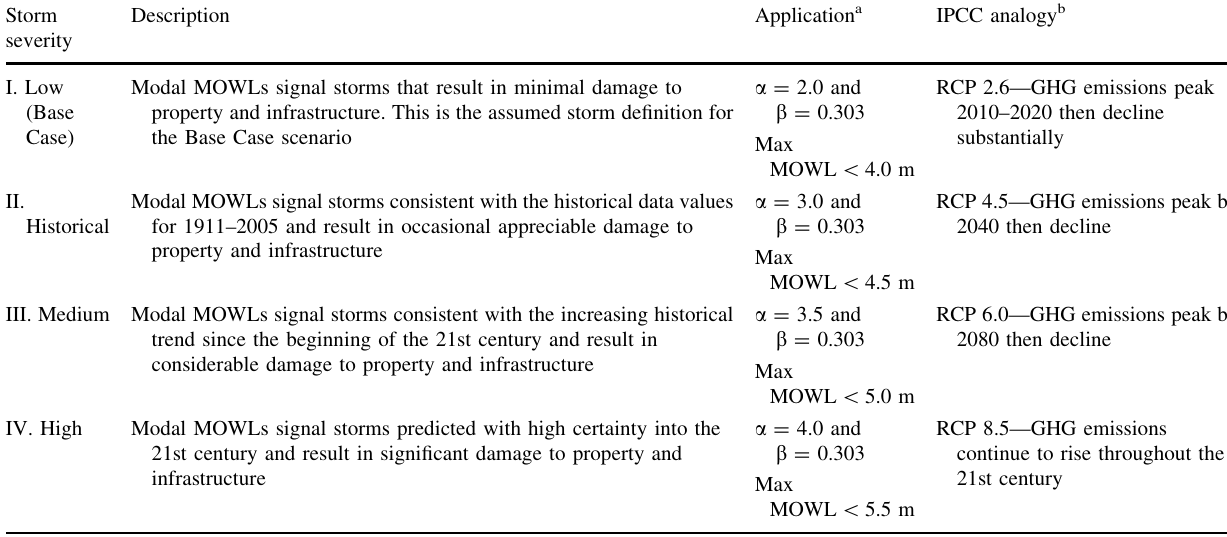
Table 4 System dynamics model uncontrollable variables—city of Charlottetown, Prince Edward Island, annual storm severity levels, maxi- mum observable water levels (MOWL)